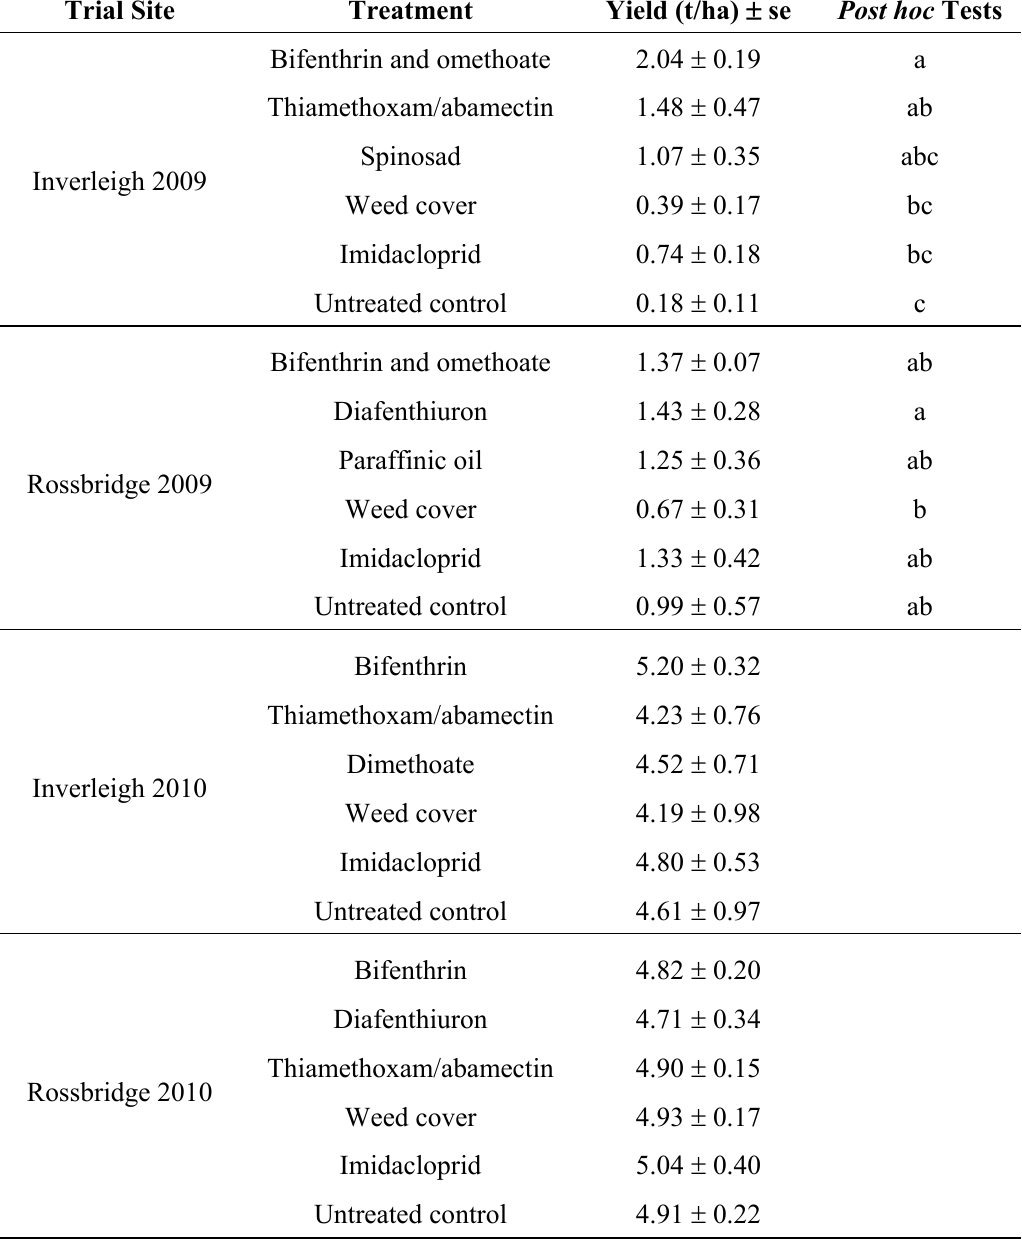
Table 5. Average yield estimates (and standard errors) at each trial site. Different letters indicate significant differences (at the p < 0.05 level, Tukey’s- b post hoc